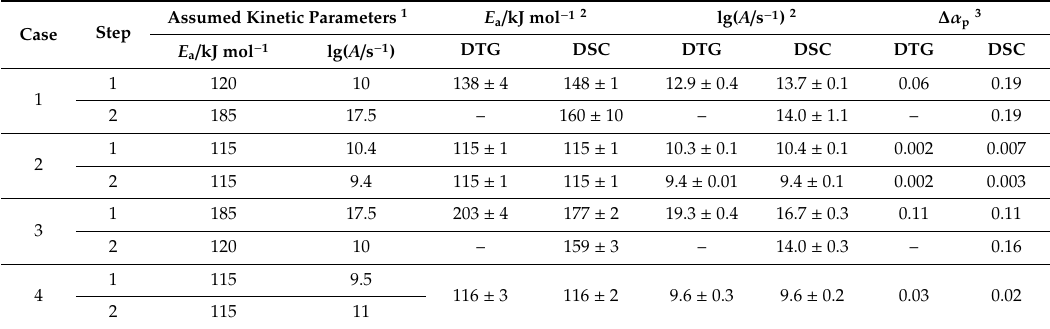
Table 1. Kinetic parameters calculated by the Kissinger plot for the simulated successive reactions of Cases